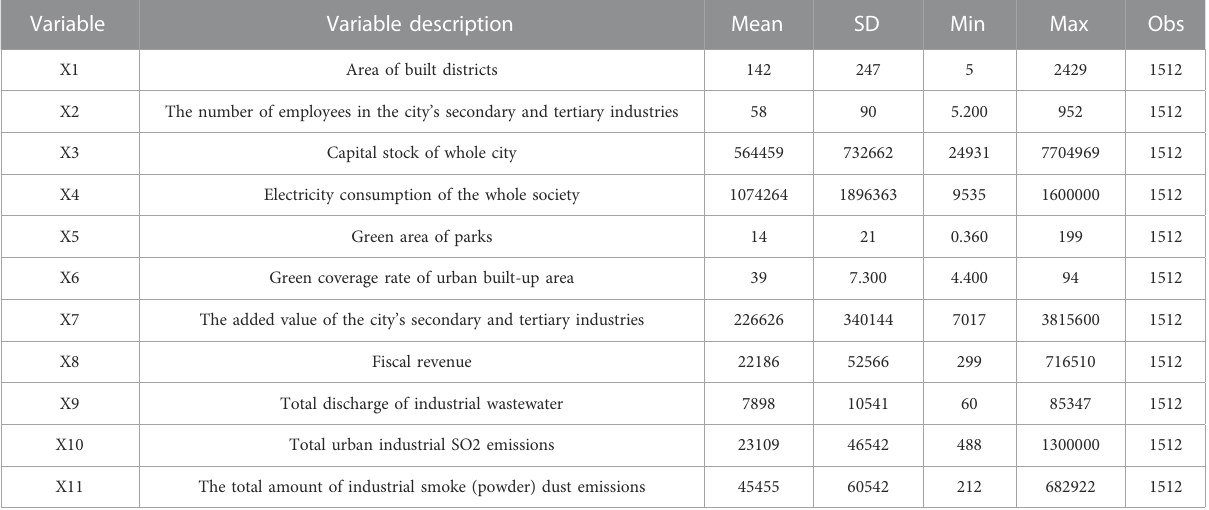
TABLE 2 Descriptive statistics of